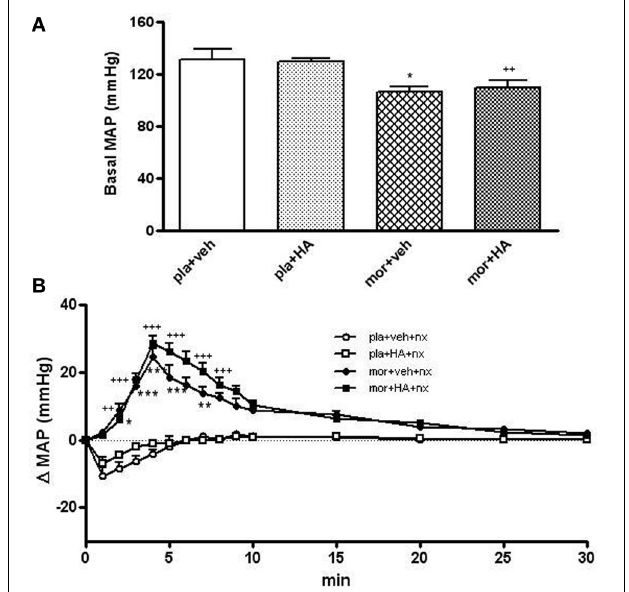
FIGURE 9 | Baseline mean arterial blood pressure (MAP, mmHg) in rats implanted with morphine (mor) or placebo (pla) pellets concomitantly with vehicle (veh) or HA-1004 (HA), just before naloxone injection (A). Effects of naloxone (2mg/kg, s.c.) on changes in MAP, in rats pretreated with mororplaconcomitantlywithvehorHA.Naloxone(nx)wasinjectedattime0 (B) . Data are the mean ± s.e.m. ( n = 4–6). ∗ p < 0 . 05, ∗∗ p < 0 . 01, ∗∗∗ p < 0 . 001 vs. pla + veh; ++ p < 0 . 01, +++ p < 0 . 001 vs. pla + HA.